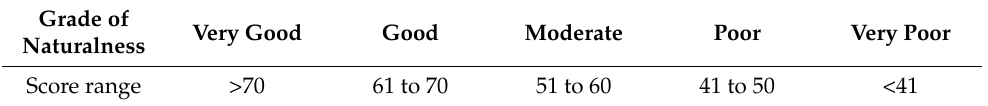
Table 2. Criteria for evaluating the naturalness of rivers based on score of riparian vegetation index in South Korea. Riparian vegetation index was obtained from the sum of score determined by multiplying the score and the weighted value of each vegetation component in Table